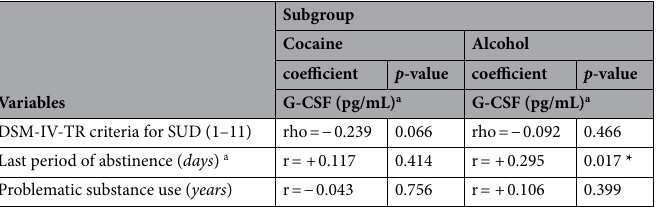
Table 2. Correlation analyses between plasma concentrations of G-CSF and relevant SUD-related variables in the SUD group. a Log 10 -transformed data. * Denotes significant difference (p < 0.05).